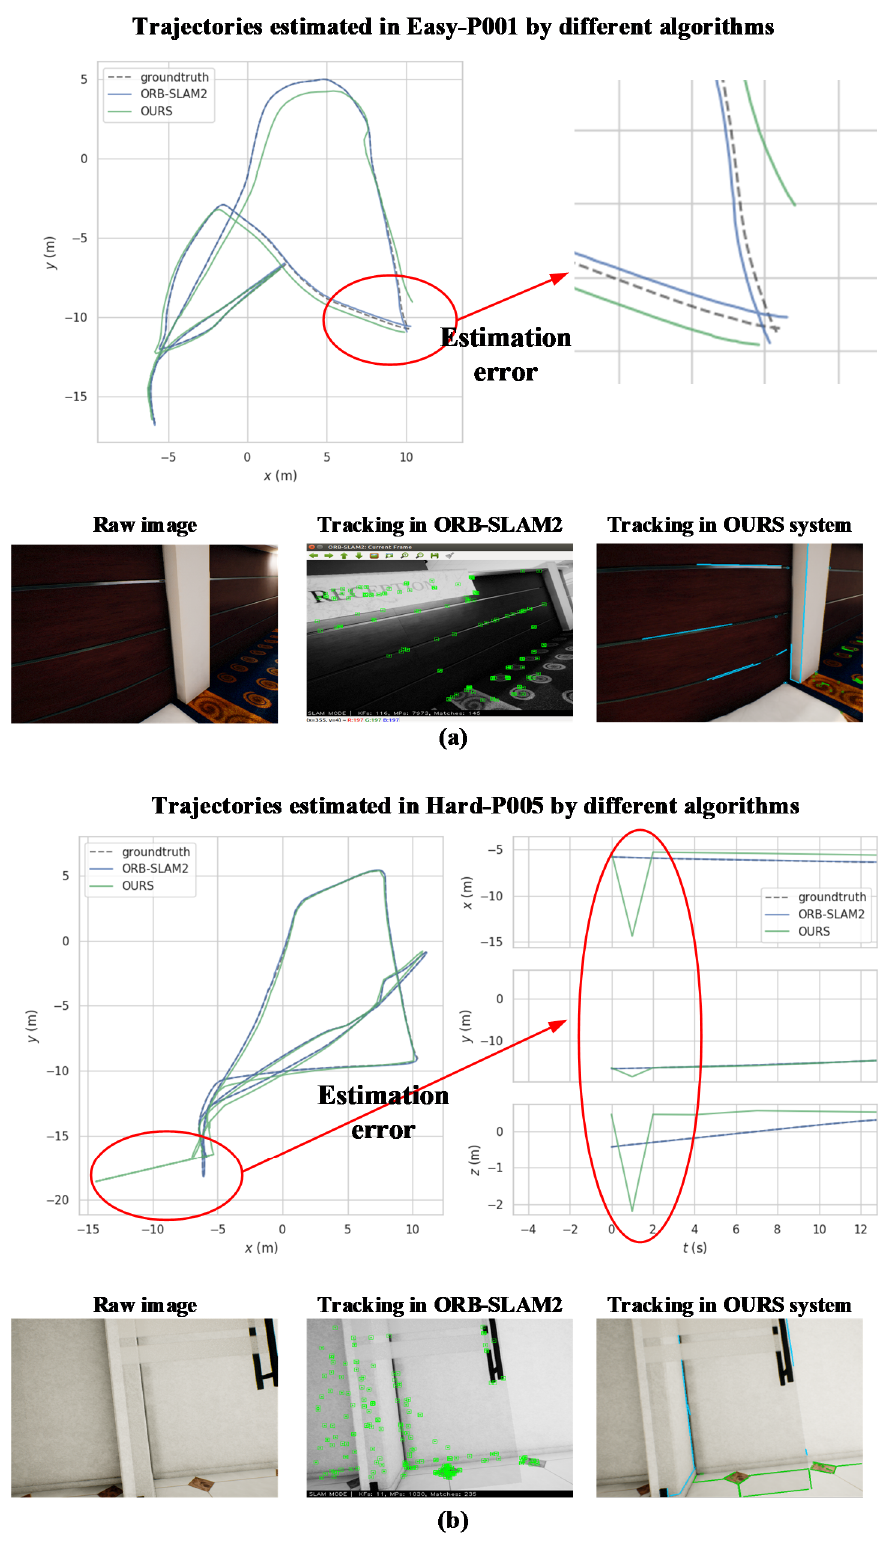
Figure 13. A motion trajectory of ORB-SLAM2 compared with our approach on Easy-P001 and Har-P005 sequences. ( a , b ) show the trajectories estimated by different algorithms in thee sequences Easy-P001 and Hard-P005, respectively. The right side of the trajectory shows a zoomed-in version of the trajectory with red circles (pose estimation error). Below the trajectories, the reasons why our system incurs a pose estimation error are shown.